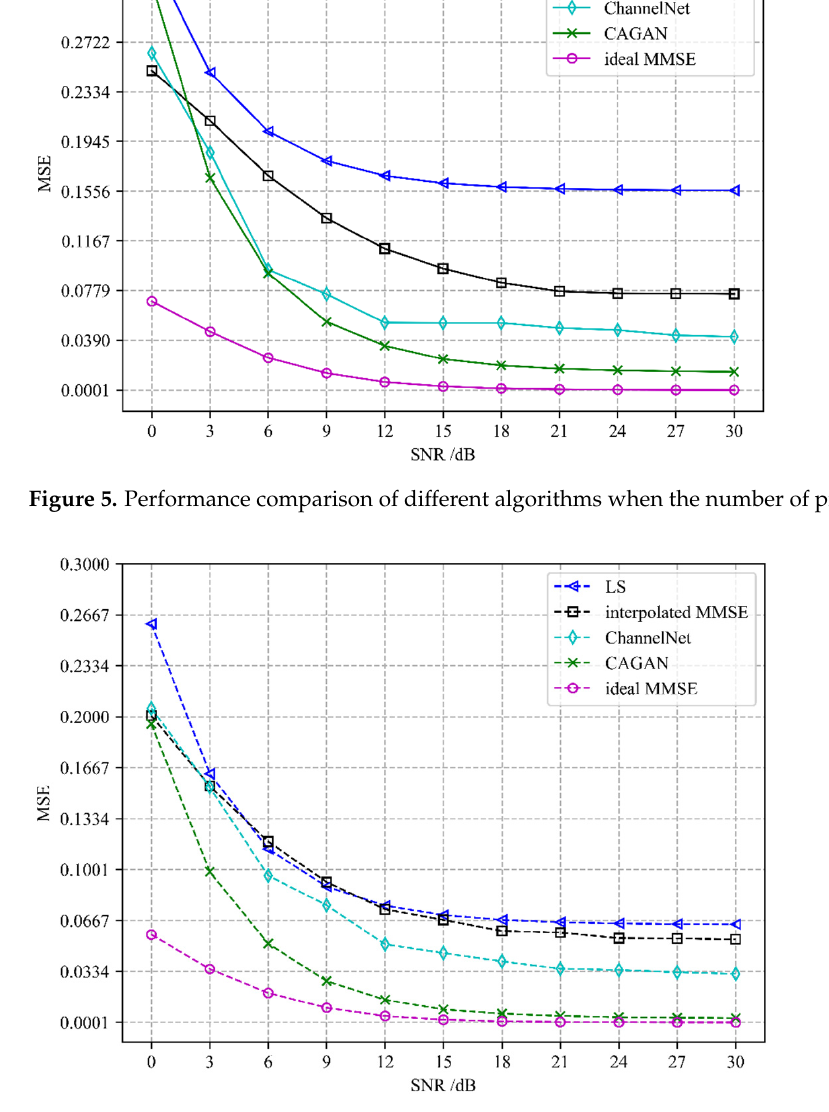
Figure 6. Performance comparison of different algorithms when the number of pilots is 16.